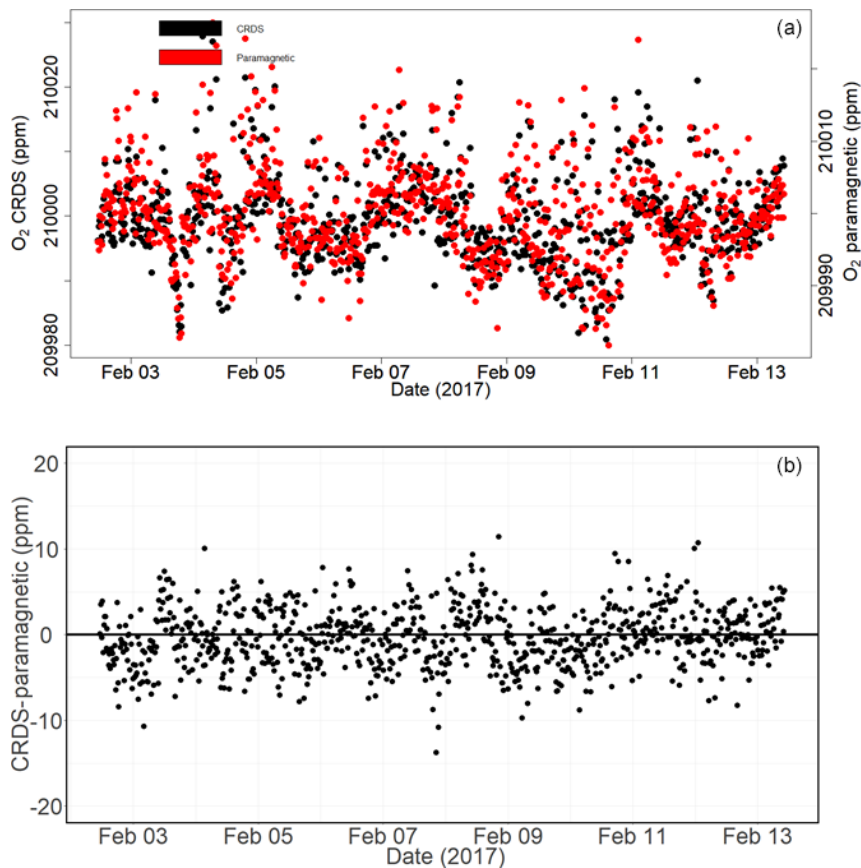
Figure 16. Calibrated ambient air oxygen measurements (1min average) at the Jungfraujoch site using the CRDS and paramagnetic analyzers (both in parts per million) (a) and the absolute difference between the two measurements (in parts per million) (b) carried out by matching time